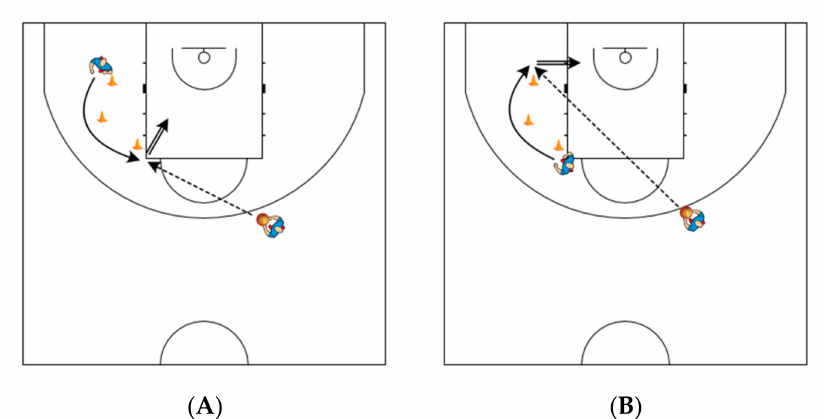
Figure 1. ( A ): 2-pt shooting after curl-cut with the angle of 60 ◦ from the backboard. ( B ): 2-pt shooting after curl-cut with the angle of 0 ◦ from the backboard.